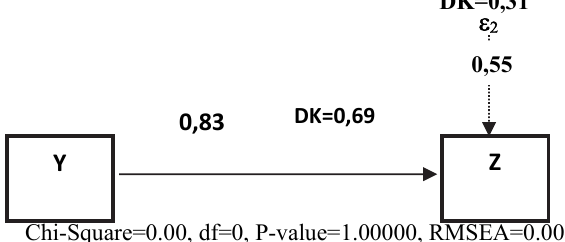
Fig. 3. Effects of Internal Elements on Mission